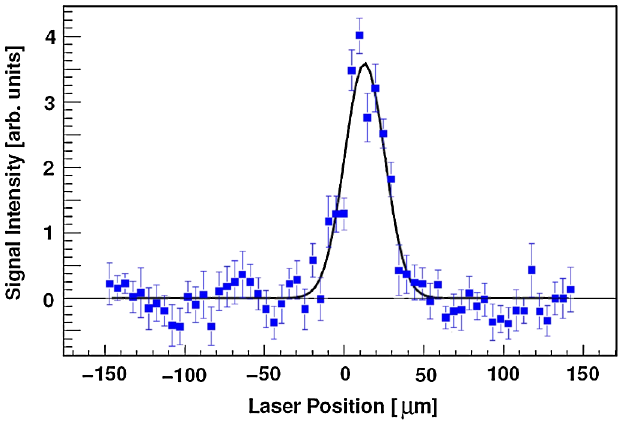
FIG. 5. (Color) Convoluted horizontal size measured by BSM in laser wire mode in March 2009.